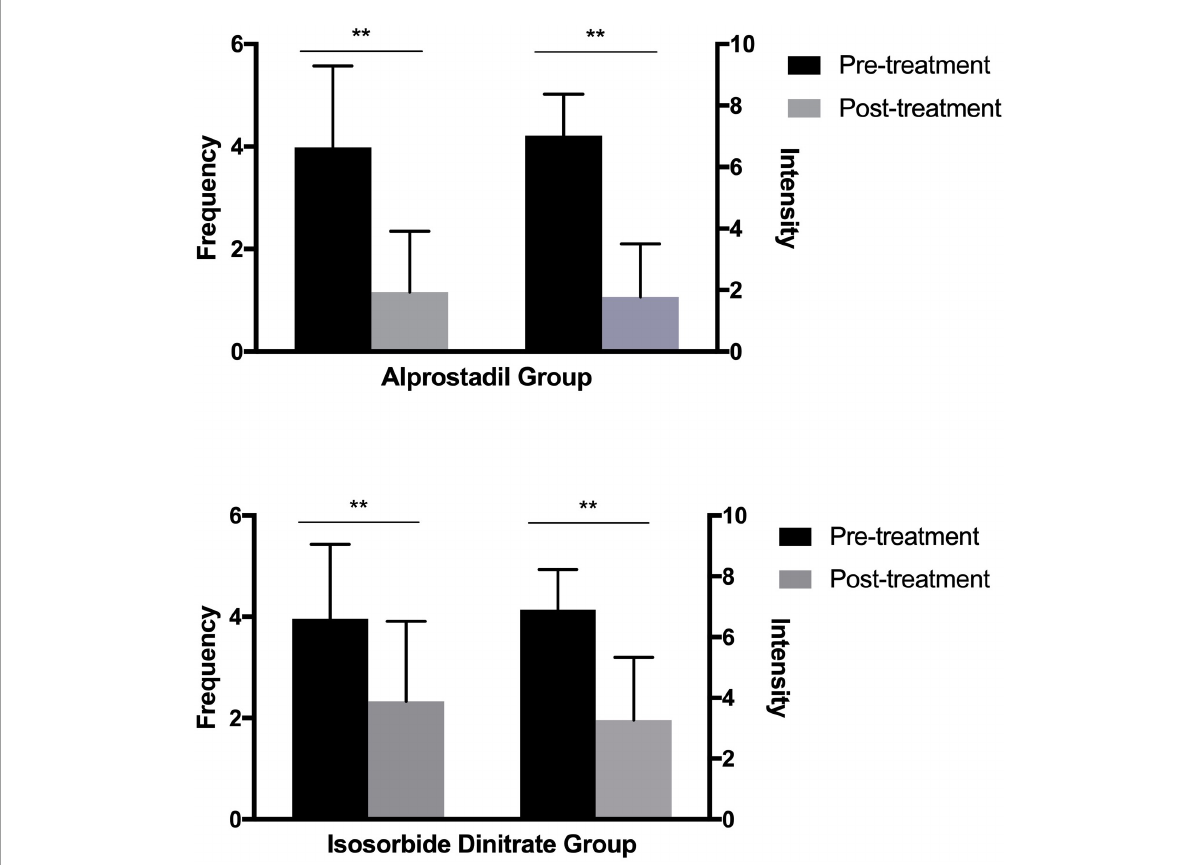
FIGURE2 Efficacy of alprostadil and isosorbide dinitrate in the amelioration of angina frequency and intensity (medians and interquartile ranges). Statistical analysis was performed using the Mann-Whitney test. ** P < 0.01.